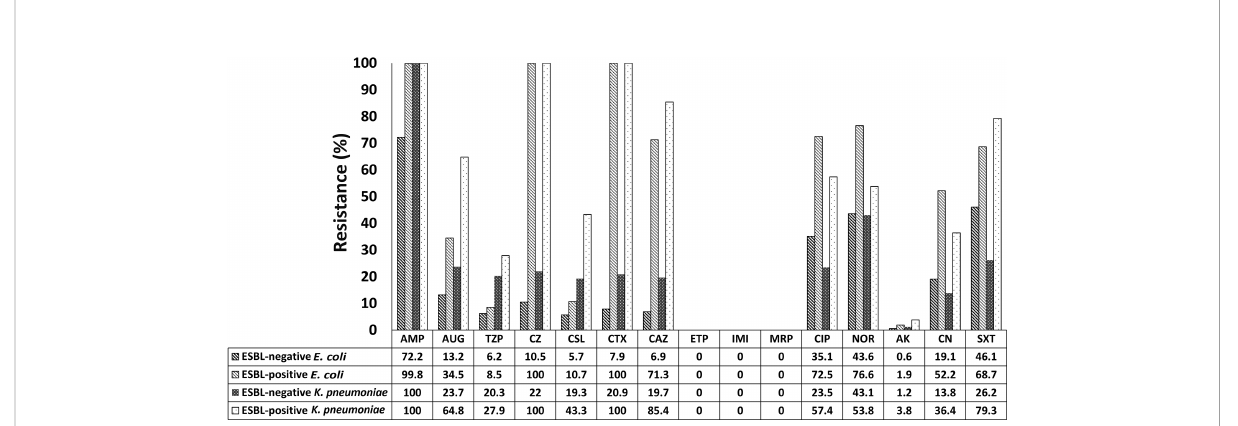
FIGURE 1 Antibiotic resistance pro fi les of ESBL-producing and non-ESBL-producing E. coli and K. pneumoniae isolated from patients admitted to Prachanukroh hospital, Chiangrai, Thailand (2016-2020). AMP, Ampicillin; AUG, Amoxicillin/Clavulanic acid; TZP, Piperacillin/Tazobactam; CZ, Cefazolin; CSL, Cefoperazone/Sulbactam; CTX, Cefotaxime; CAZ, Ceftazidime; ETP, Ertapenem; IMI, Imipenem; MRP, Meropenem; CIP, Cipro fl oxacin; NOR, Nor fl oxacin; AK, Amikacin; CN, Gentamicin; SXT,